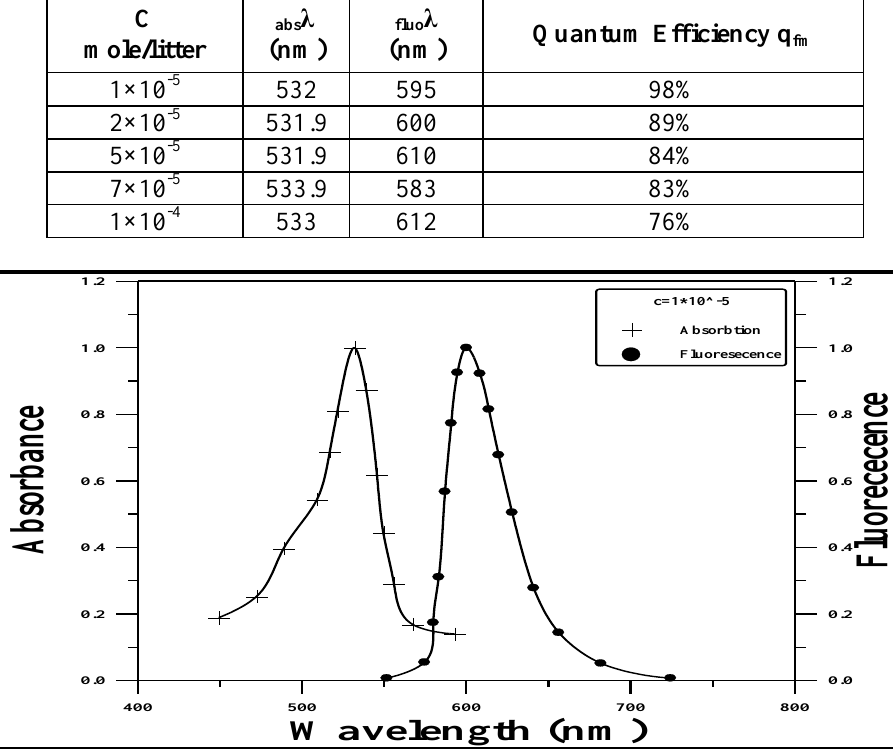
Fig.1: The absorption and fluorescence spectrum of R6G dye doped PMMA for concentration 1×10 -5 mol/ ℓ at thickness